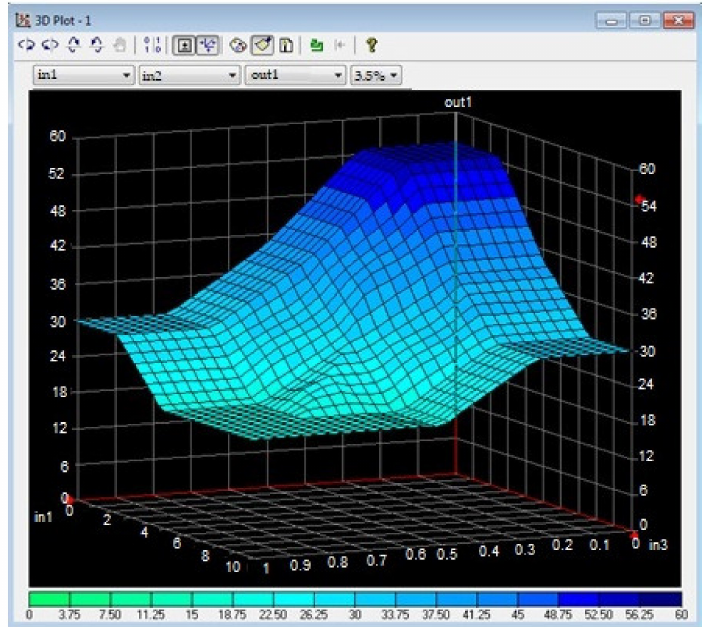
Figure 11. Surface plot out1 (optimal speed of the vehicle approaching the intersection) ( in1 (the number of cars waiting at the intersection), and in3 (the proportion of large vehicles waiting at the